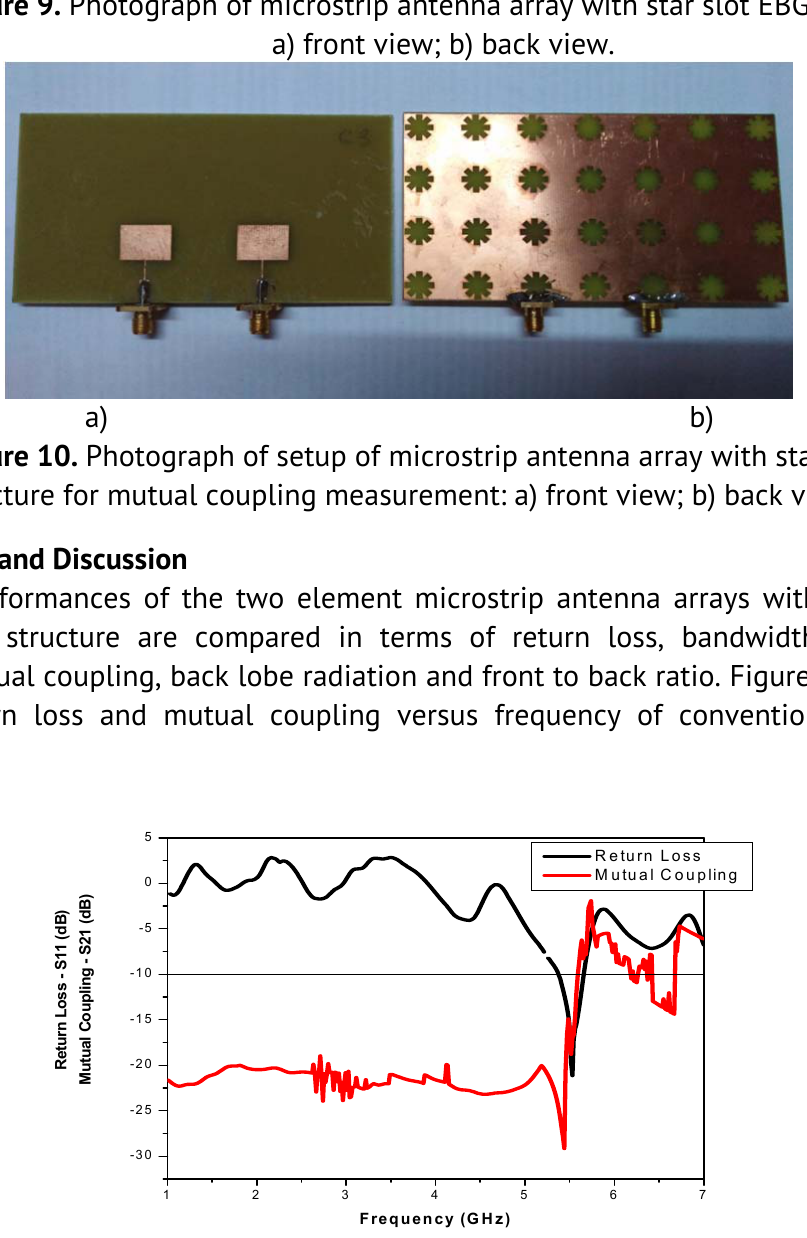
Figure 11. Graph of return loss and mutual coupling – S conventional microstrip antenna